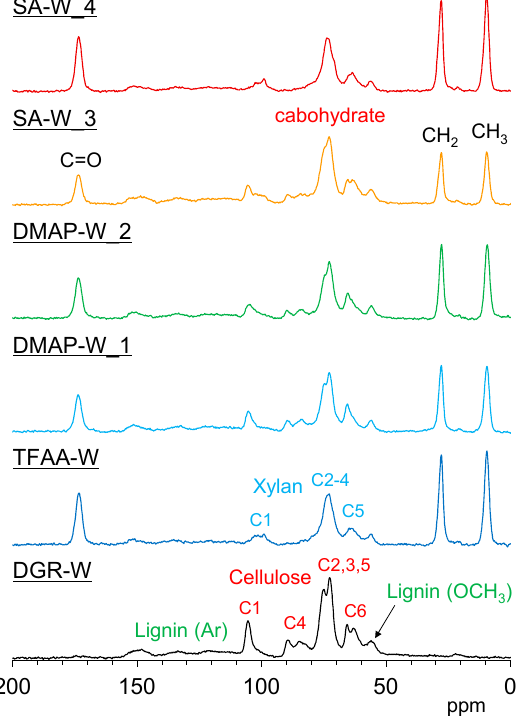
Figure 12. 13 C cross-polymerization (CP)-MAS NMR spectra of degreased wood (black) and propionylated wood samples ( TFAA-W , blue; DMAP-W_1 , light blue; DMAP-W_2 , green; SA-W_3 , orange; and SA-W_4 , red).